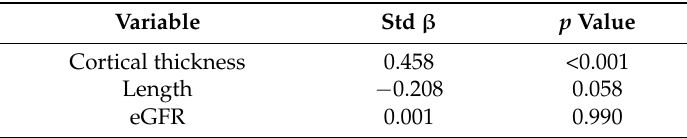
Table 4. Multiple linear regression analysis: association between decline in kidney function and morphological parameters.